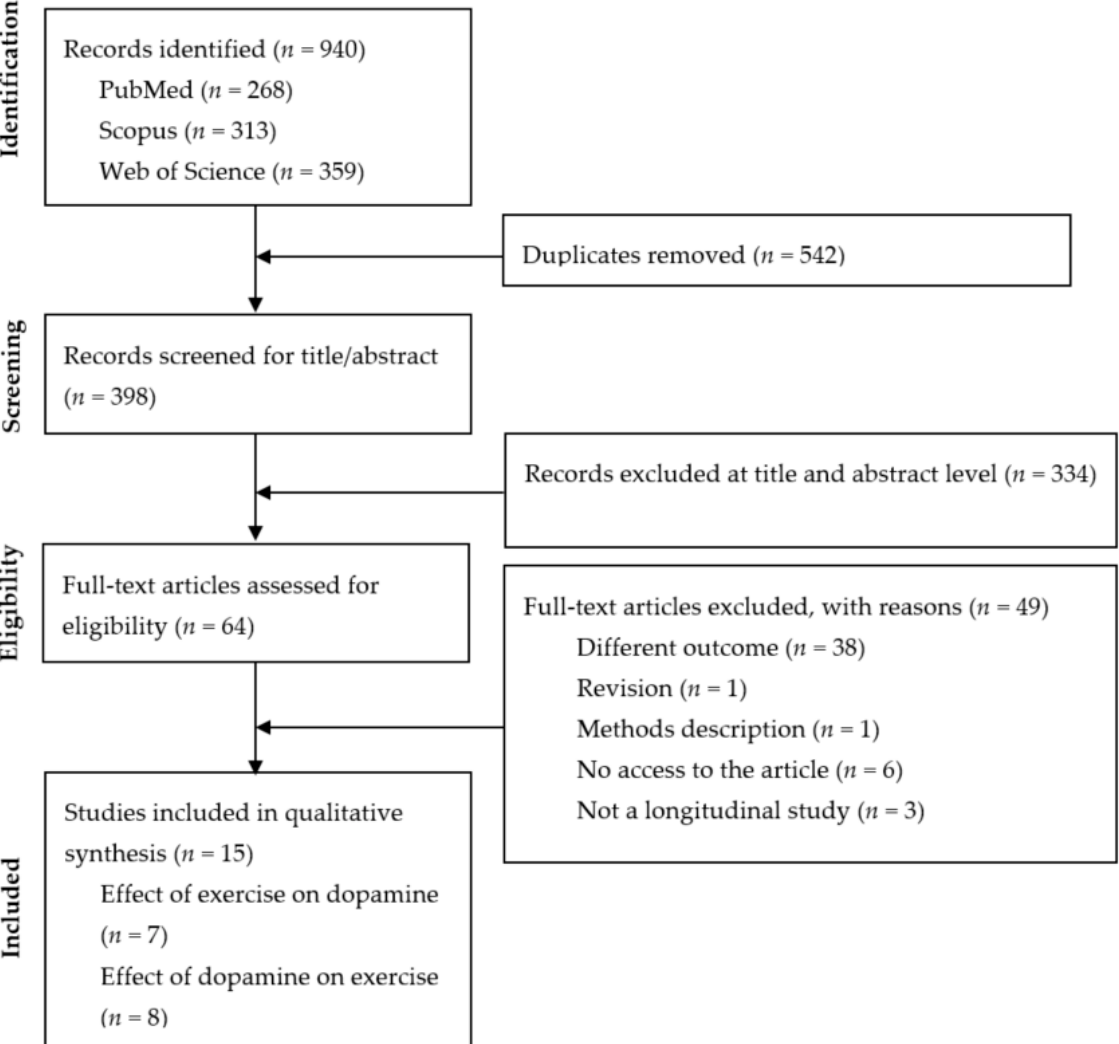
Figure 1. Flow diagram of study selection.